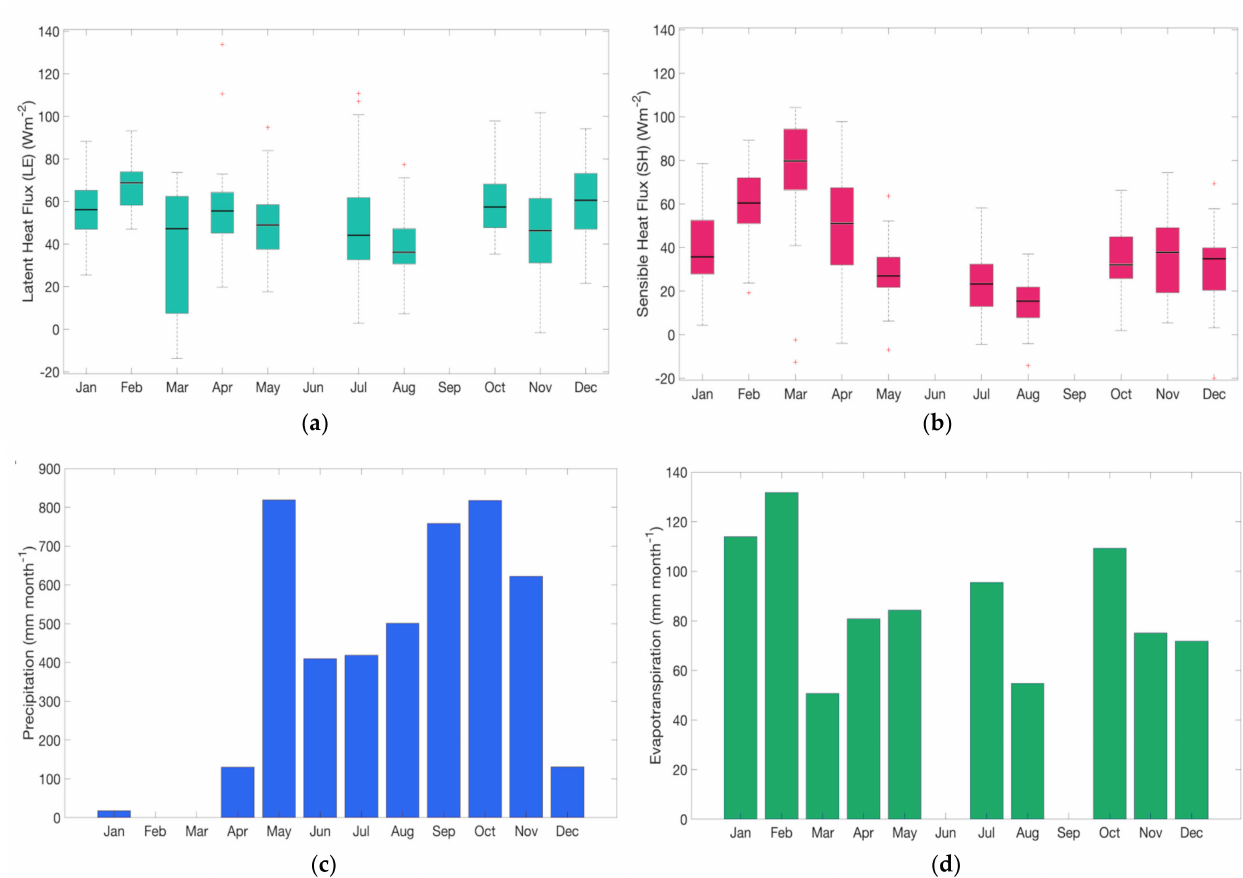
Figure 7. Preliminary results for the annual cycle of the average ( a ) latent heat flux (LE) and ( b ) sensible heat flux (H) and the monthly accumulated ( c ) precipitation and ( d ) evapotranspiration (E) for 2020 in the sun-grown coffee crop, according to EC measurements. Flux responses to the establishment of the rainy season around May can be observed. In the fluxes convention used, positive (negative) represents the up (down)